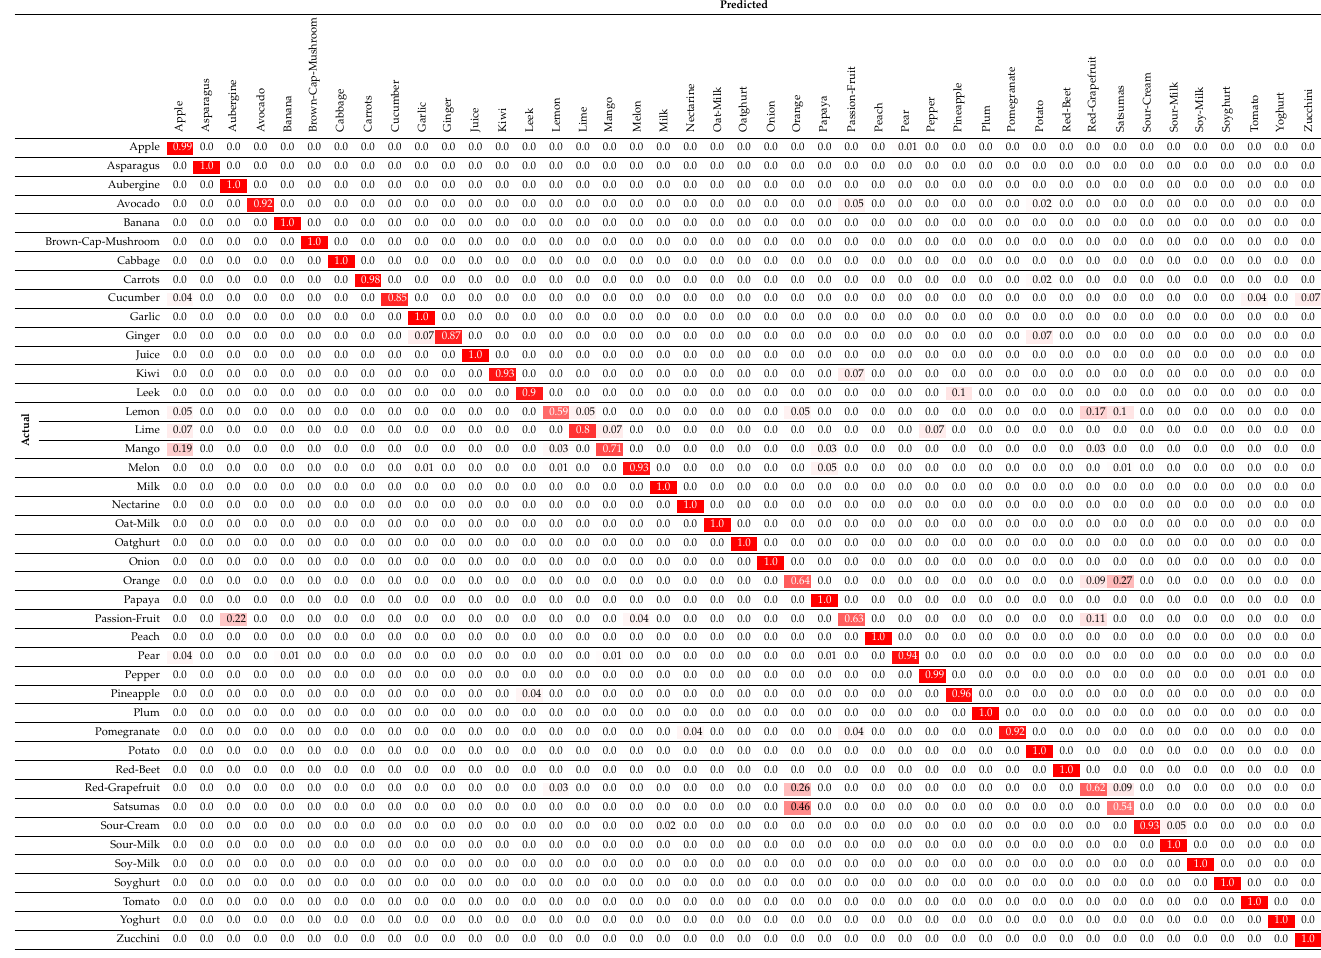
Table 1. Confusion Matrix of the ResNeXt-101 model with 20% dropout.